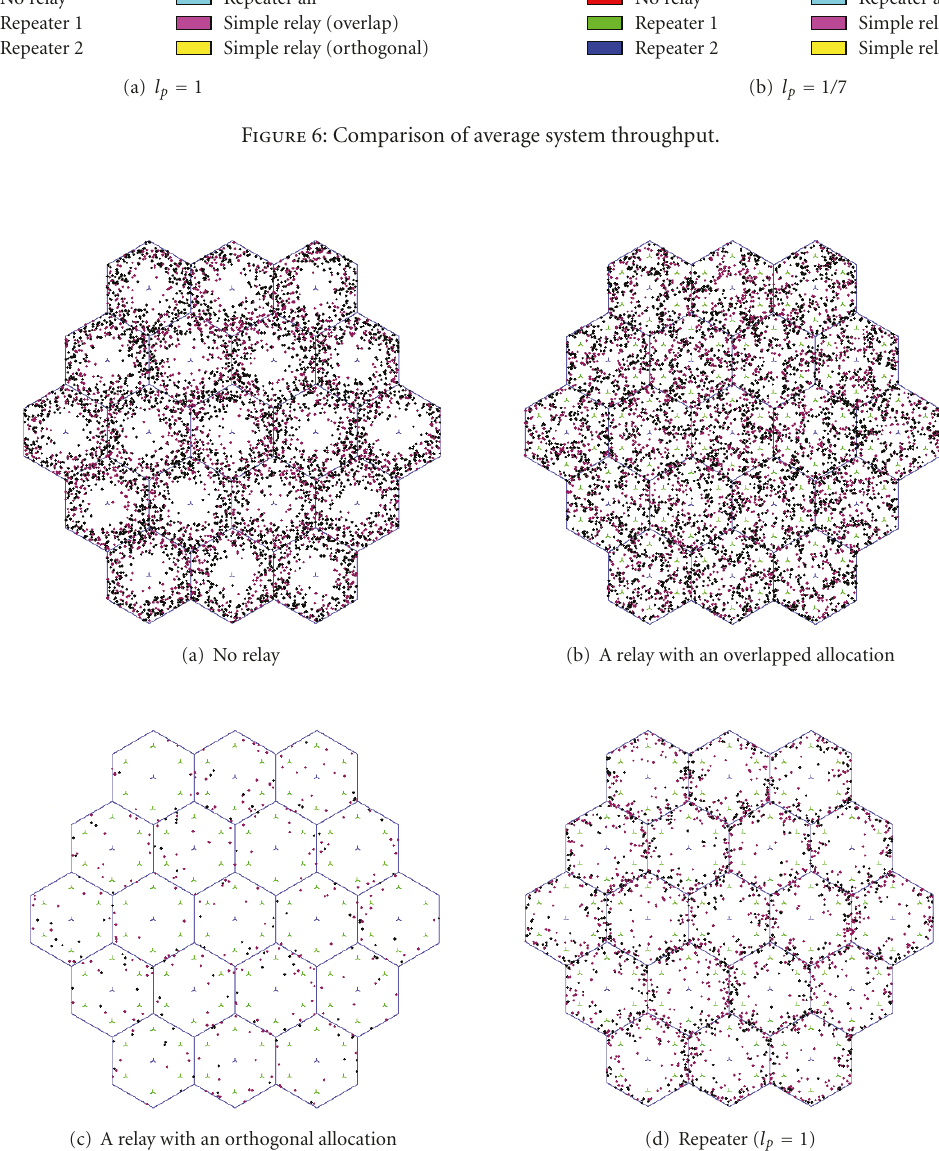
Figure 7: Comparison of cellular outage performance (black dot denotes an MS subject to